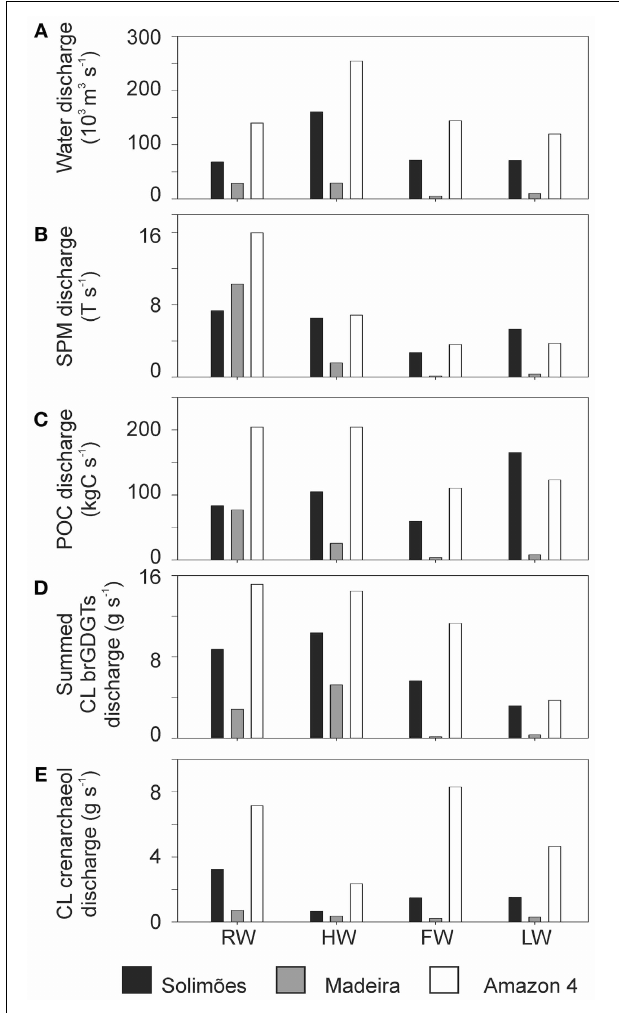
FIGURE 10 | Comparisons of (A) river water discharge (10 3 m 3 s − 1 ) with (B) SPM discharge (T s − 1 ), (C) POC discharge (kgC s − 1 ), (D) CL brGDGT discharge (g s − 1 ), and (E) CL crenarchaeol discharge (g s − 1 ) at Solimões, Madeira and Óbidos